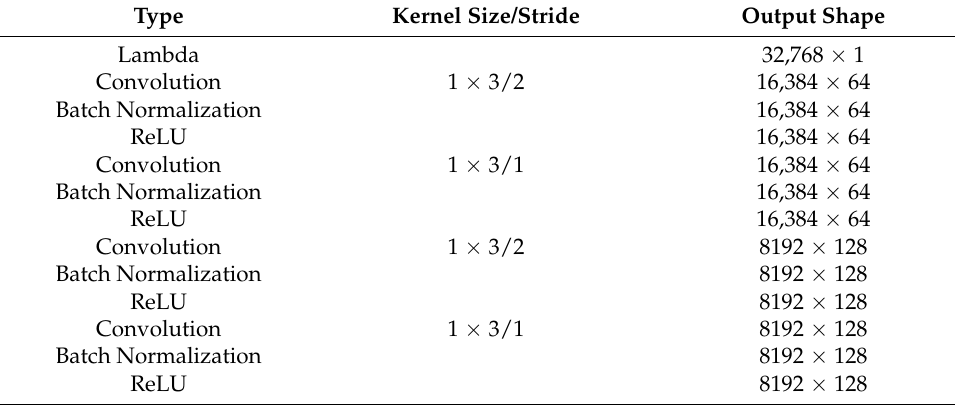
Table 1. Partial network structure and parameters in encoder.